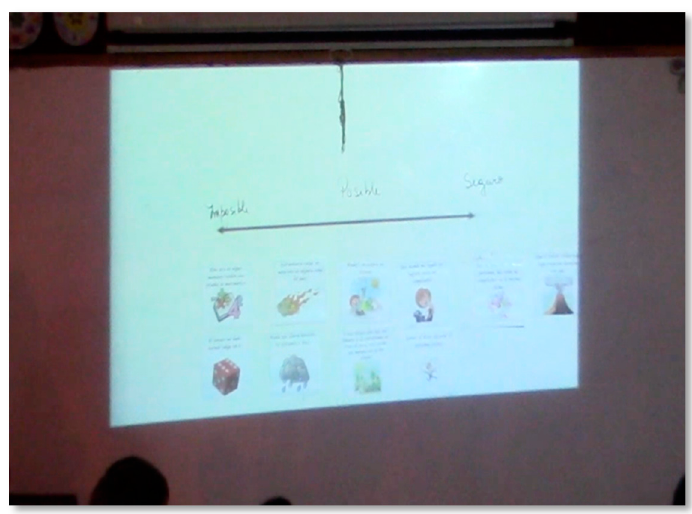
Figure 6. Image capture for 5th grade class.